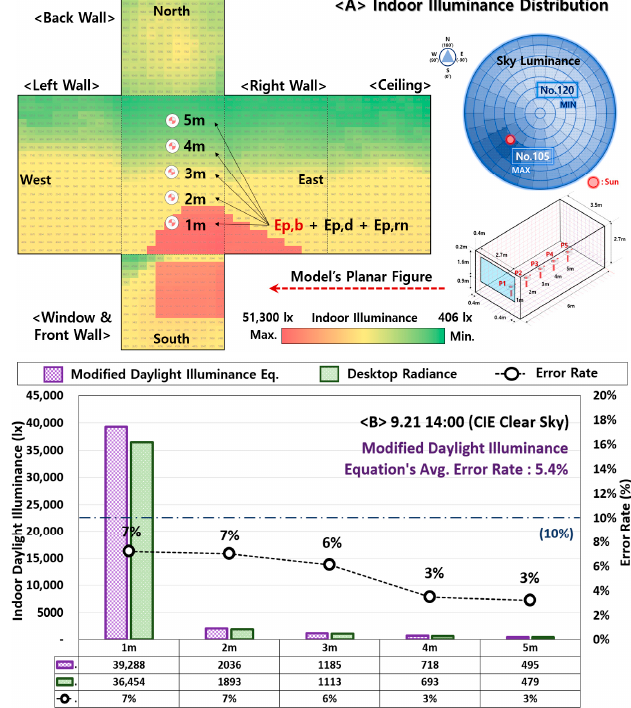
Figure 16. Indoor illuminance distribution of the six–side planar figure and comparison of illuminance between the modified equation and Desktop Radiance (CIE Clear Sky_9.21 14:00).